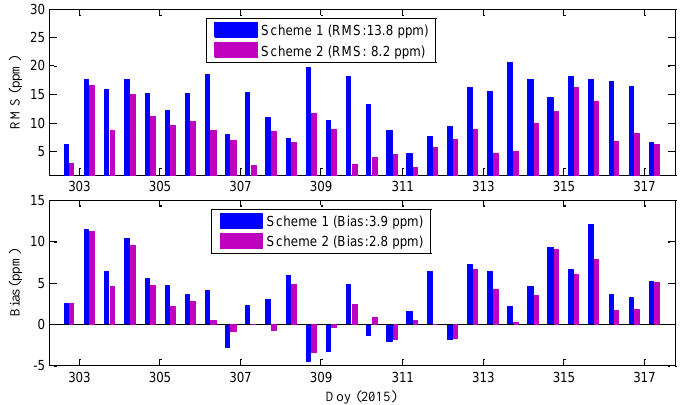
Figure 8. The RMS (Root Mean Square) error and Bias between raidosonde and two schemes for the Doy 303 to 317, 2015.